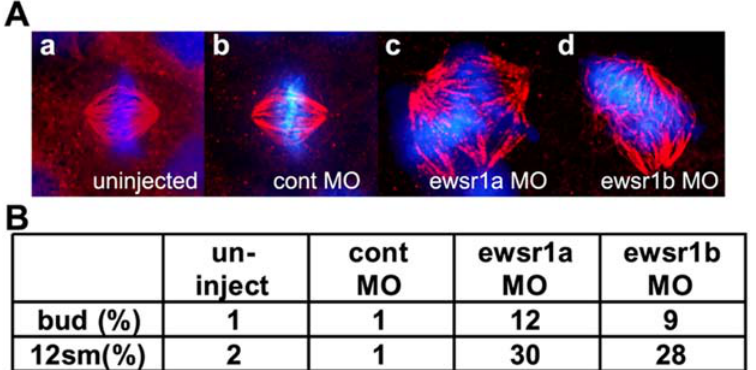
Figure 7. ewsr1MO Injected Zebrafish Embryos Display Mitotic Defects. A. Representative images of mitotic spindles from (a) uninjected, (b) control MO, (c) ewsr1a MO and (d) ewsr1b MO injected embryos. DNA was stained with DAPI (blue) and the spindles were visualized by a -tubulin staining (red). B. Score of abnormal mitotic spindles of uninjected, control MO, ewsr1a MO and ewsr1b MO injected embryos at the bud and the 12 somite stages (12sm). Approximately two hundred mitotic spindles (N=193–234) were examined for each group.